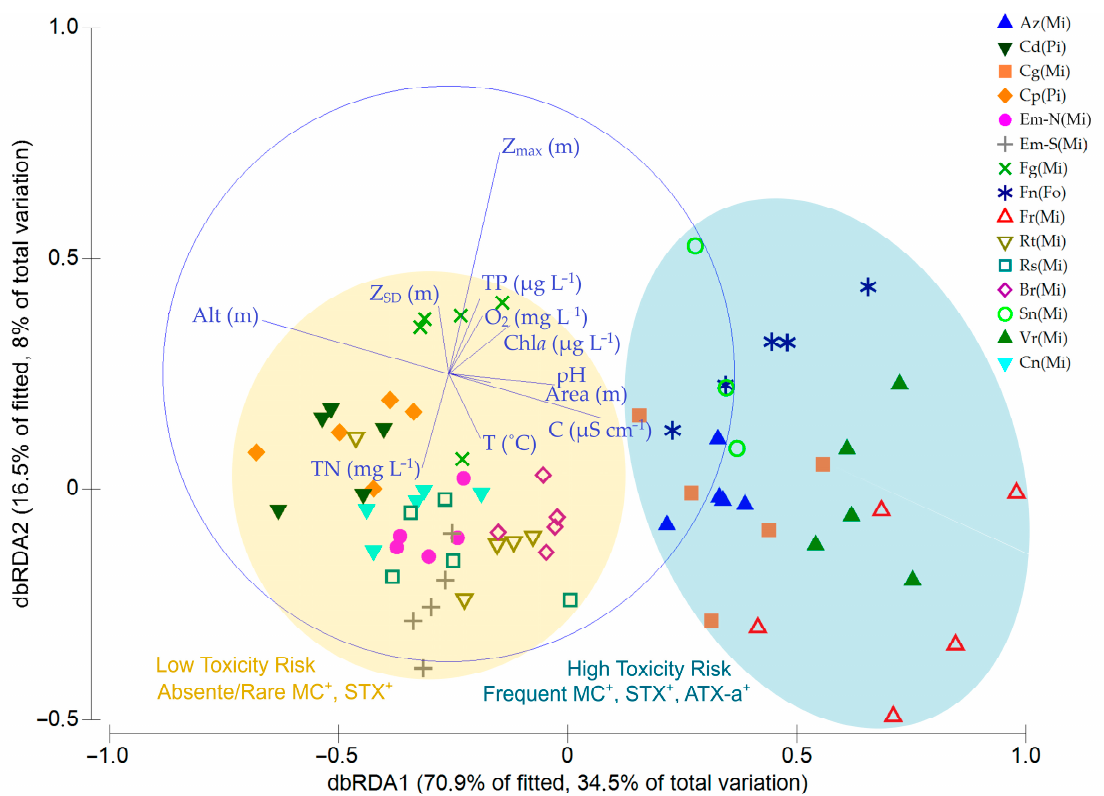
Figure 4. Distance-based redundancy analysis (dbRDA) plot of Distance-based linear modeling (DistLM) results in 2-dimensional space for environmental variables and cyanotoxin genes amplification across the studied lakes. The length and direction of the vectors represent the strength and direction of the relationship (see Table 1 for environmental variables and lake codes). MC + = amplification of MC producing gene(s), STX + = amplification of STX producing gene(s), ATX-a + = amplification of ATX-a producing gene(s).